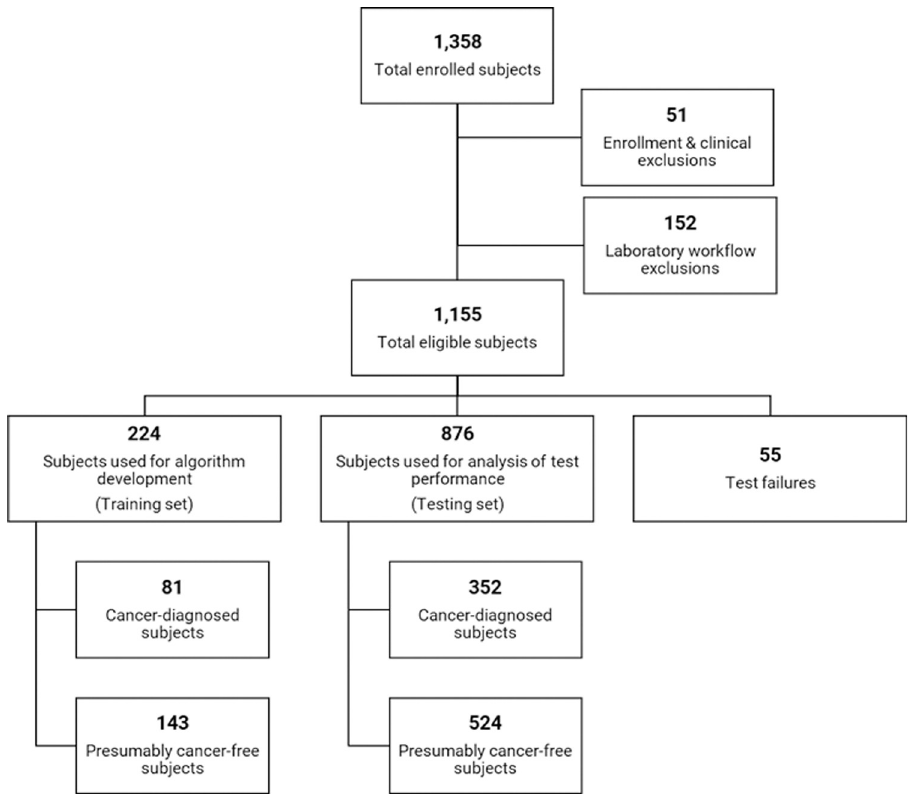
Fig 1. Disposition of subjects in the CANDiD